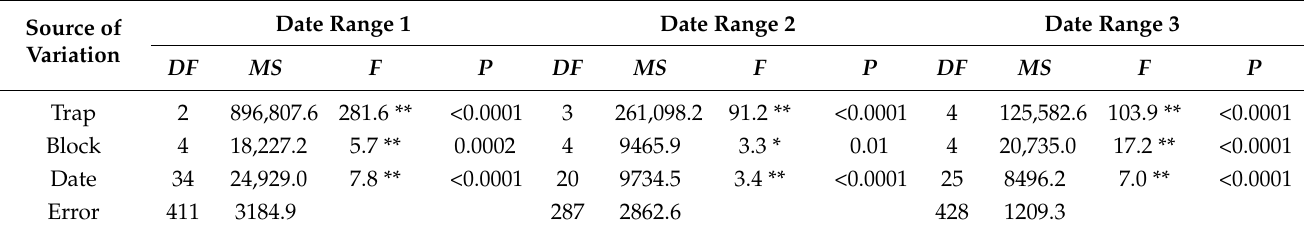
Table 3. Analysis of variance of trapped moths for different traps in 2020.